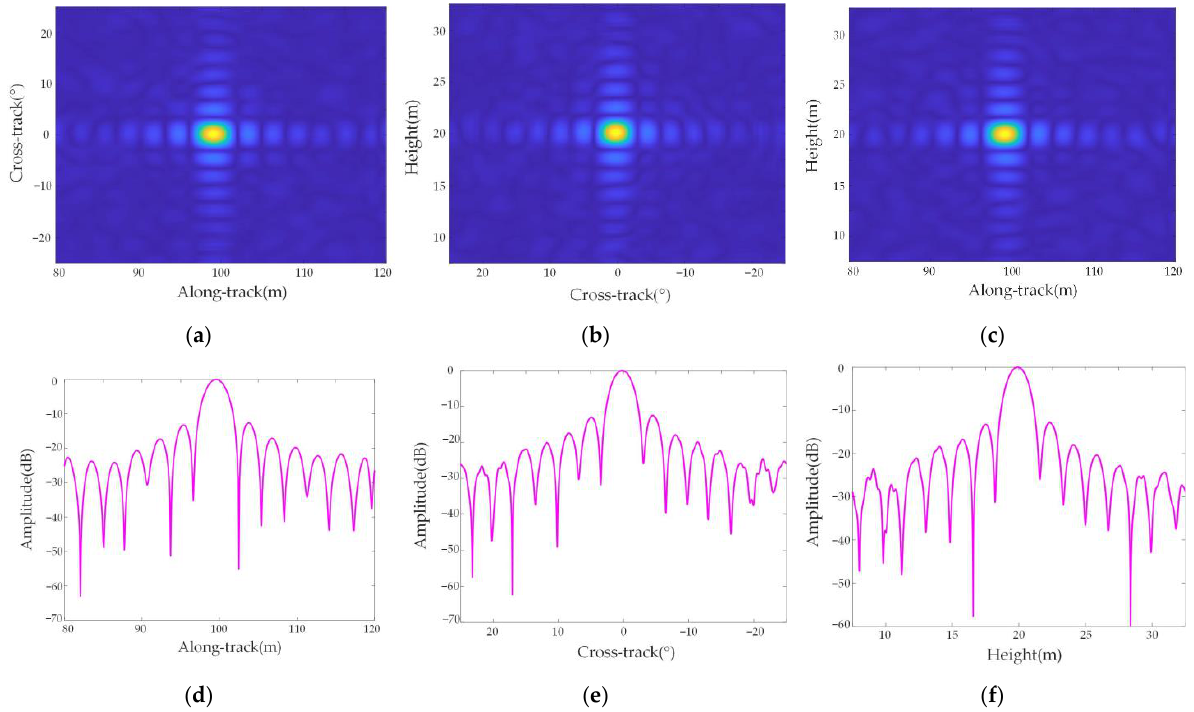
Figure 10. Point P5 3D sectional view and point target quality analysis. ( a ) Along-track-cross-track sectional view; ( b ) cross-track-height direction section view; ( c ) Along-track-height direction section view; ( d ) Along-track PSLR; ( e ) Cross-track PSLR; ( f ) Height PSLR.